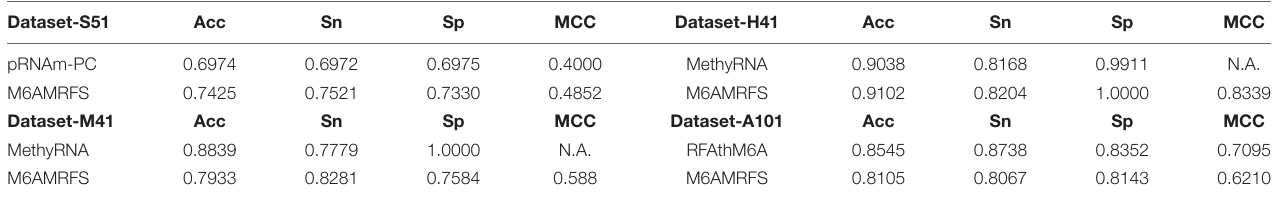
TABLE 5 | Results of the proposed predictor and the state-of-the-art predictors on benchmark datasets from different